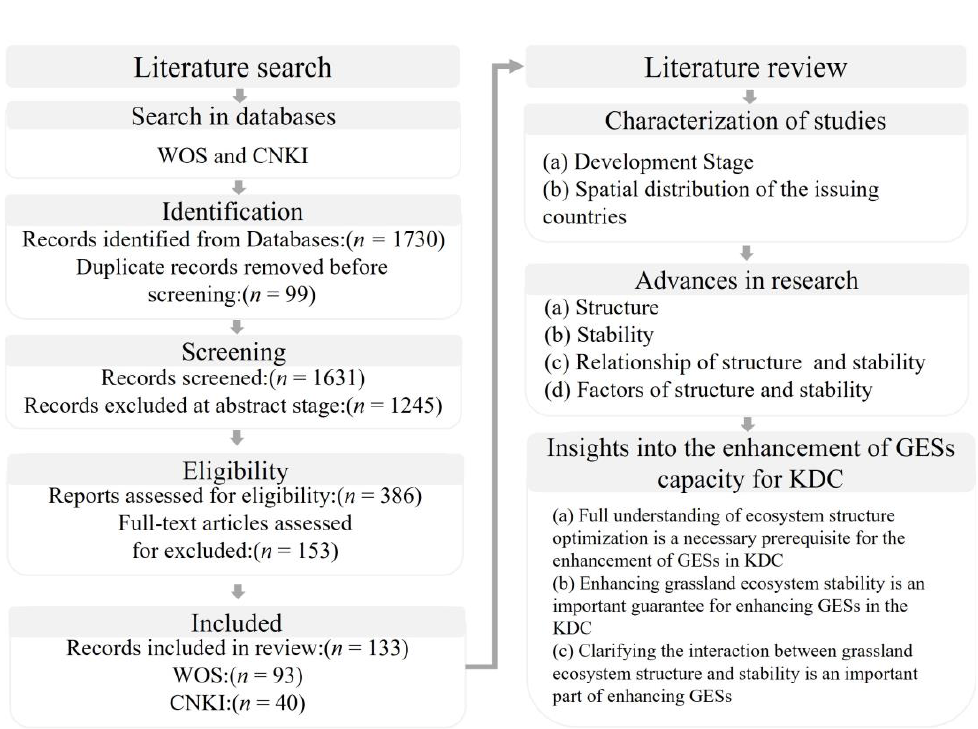
Figure 5. The flow diagram showing the steps of the methodology and selection process used for the systematic literature review on the left and the literature review process on the right.